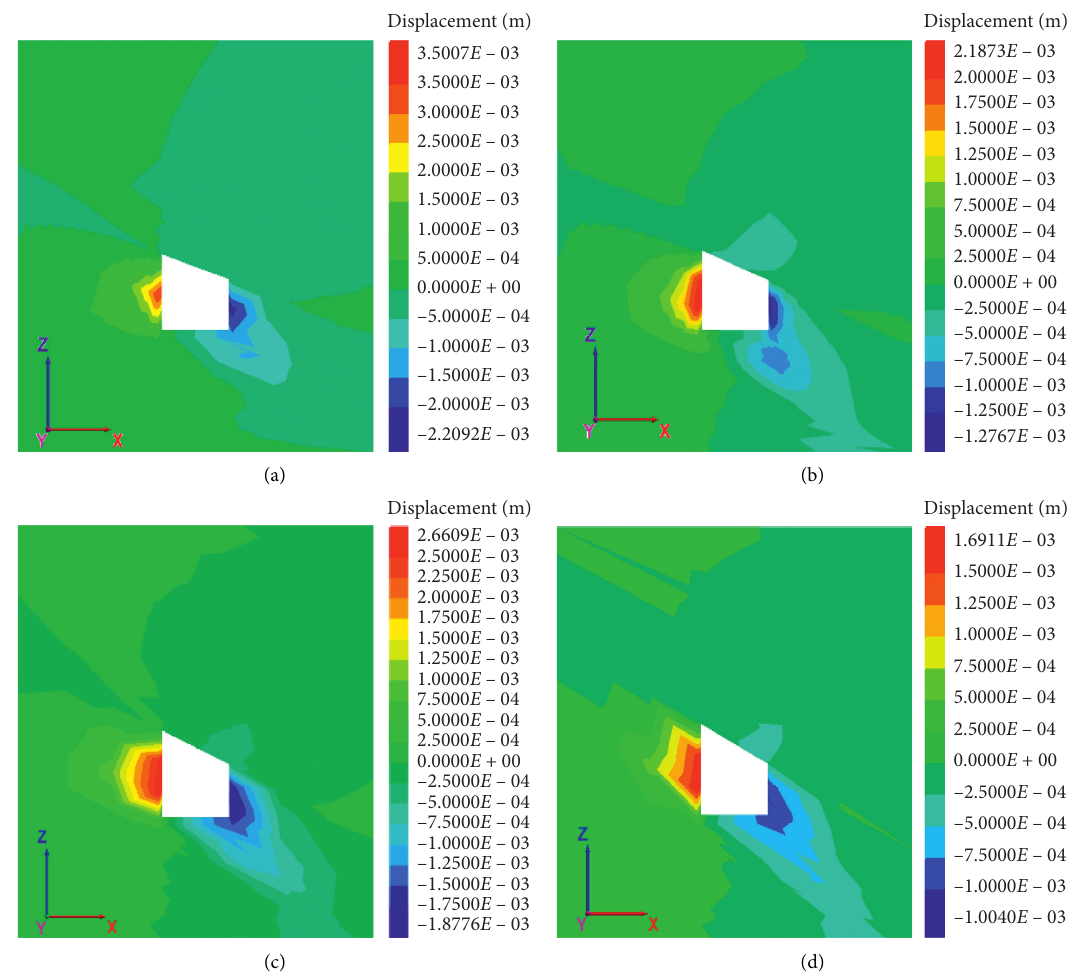
Figure 9: Horizontal stress distribution characteristics of the roadway. (a) 18 ° . (b) 21 ° . (c) 24 ° . (d) 27 ° .